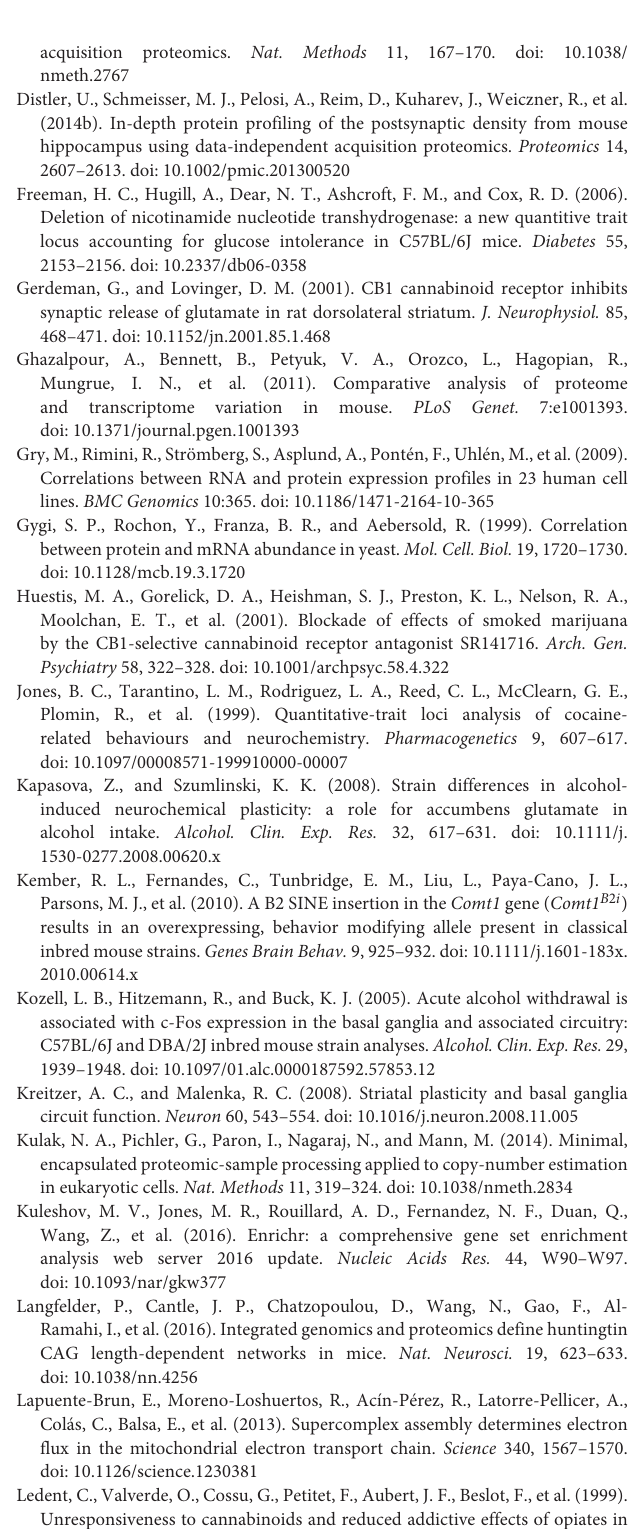
TABLE S1 | Detected proteins. TABLE S3 | DE Proteins (FDR < 10%).